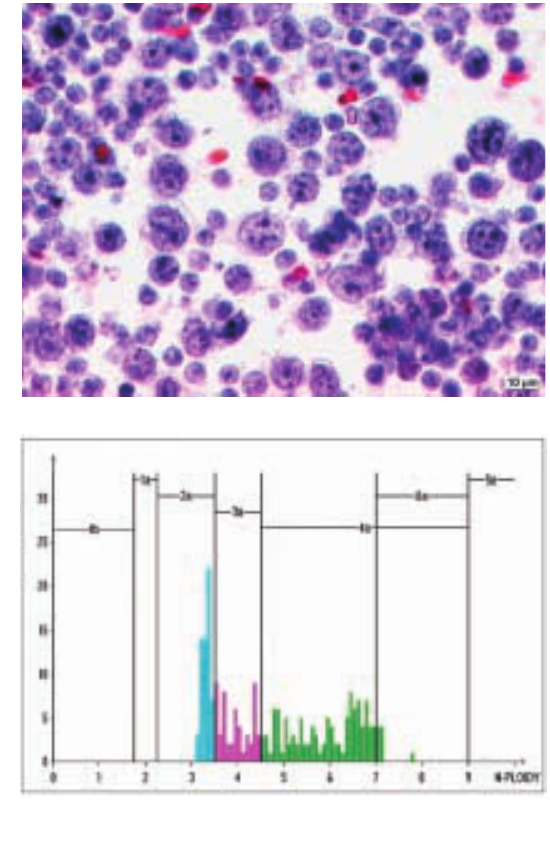
DNA histogram of pericardial fluid in patient (2) revealing significant DNA aneuploidy. Abcissa: DNA values in c-units; ordinate: number of measured nuclei. DNA mean value 4.93 (normal 2.0), DNA index 2.47 (normal 1.0), 2c devi-